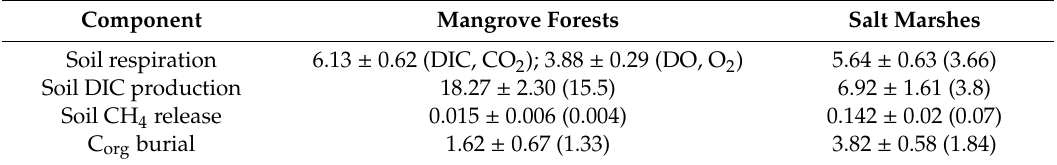
Table 3. Comparison of mean ( ± 1SE) rates of soil respiration, dissolved inorganic carbon (DIC) production (to a depth of 1 m), CH 4 release and C org burial between mangrove and salt marsh ecosystems. Units = Mg C ha − 1 a − 1 . Soil respiration data averages measurements taken at the soil surface during air exposure and tidal inundation and includes both gas (O 2 and CO 2 ) and solute (dissolved oxygen (DO) and DIC) measurements together for salt marshes and separately for mangroves. Mangrove oxygen and carbon fluxes are kept separate because of significant di ff erences [94].